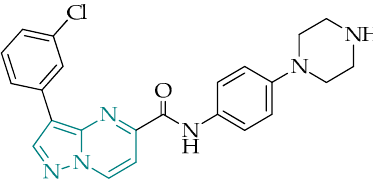
Figure 5. Structural representation of pyrazolo[1,5- a ]pyrimidine MMV022478, identified by Spalenka’s group [31], highlighting the pyrazolo[1,5- a ]pyrimidine frame.